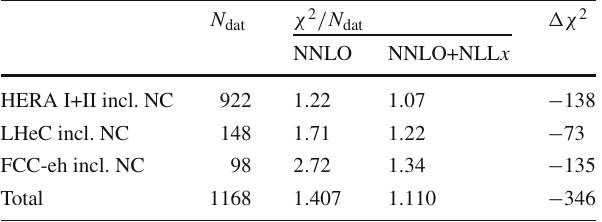
Table 7 Same as Table 3 for the NNPDF3.1sx NNLO and NNLO+NLL x fits including both the LHeC and the FCC-eh pseudo- data. We show only the χ 2 / N dat values for the HERA inclusive cross- sections and for the LHeC and FCC-eh pseudo-data, since for all other experiments the values presented in Table 3 are essentially unchanged. The last row corresponds to the sum of the three experiments listed on the table N